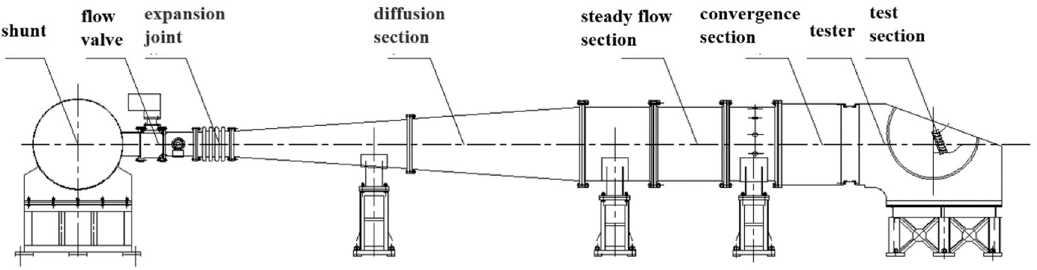
Figure 8. Schematic diagram of test system.